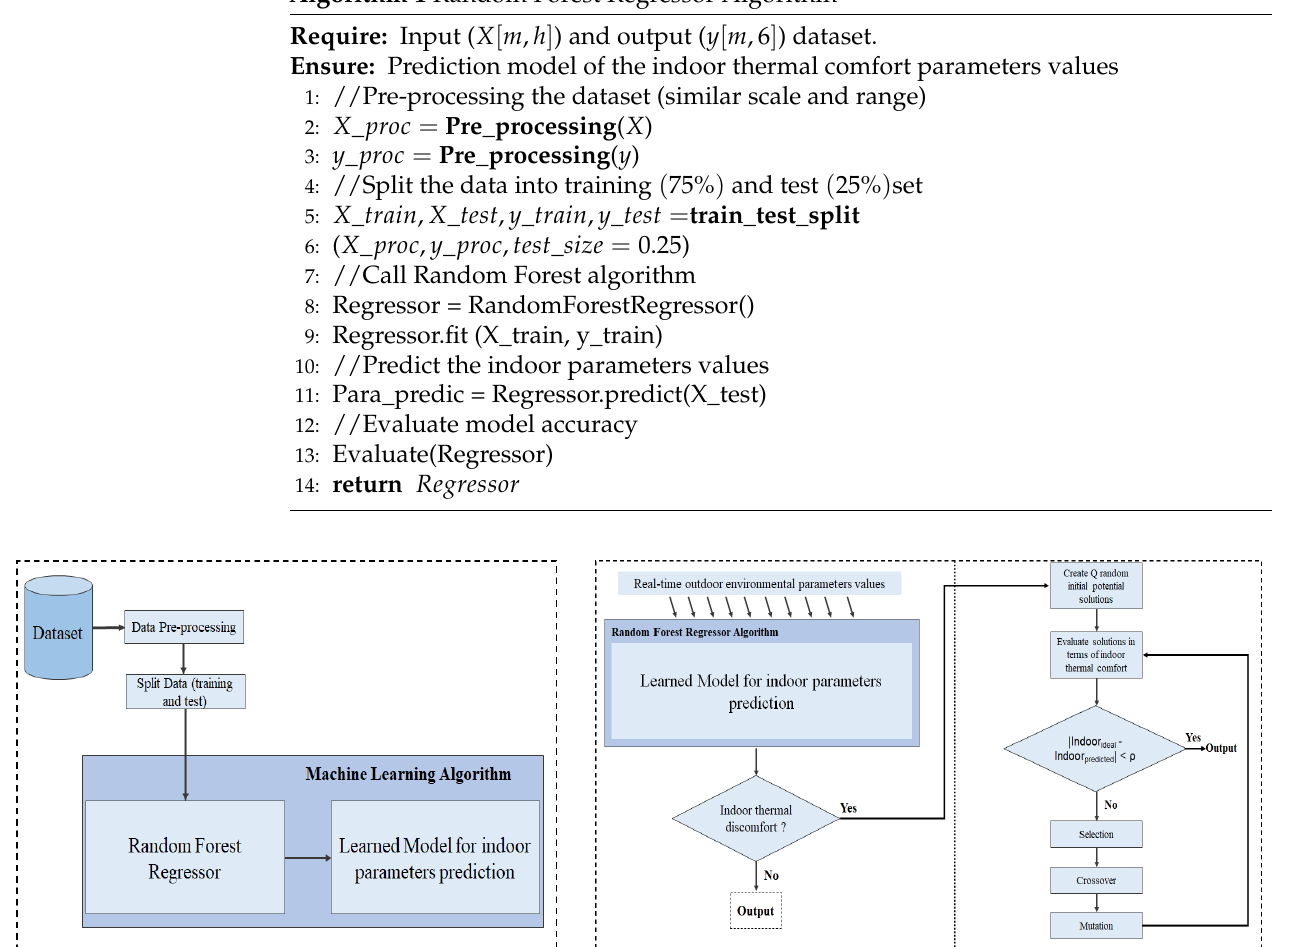
Algorithm 1 Random Forest Regressor Algorithm